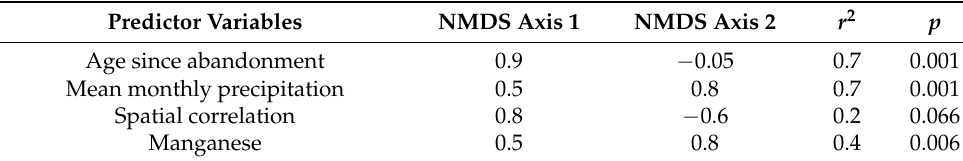
Figure 5. Non-multidimensional metric scaling analysis (NMDS) to visualize the dissimilarity of floristic group composition and its relationship with environmental variables. FG: floristic group; MAT: mean annual temperature; MMP: mean monthly precipitation; SC: spatial correlation; Mn: manganese. Table 3. Significant predictors variables with the NMDS